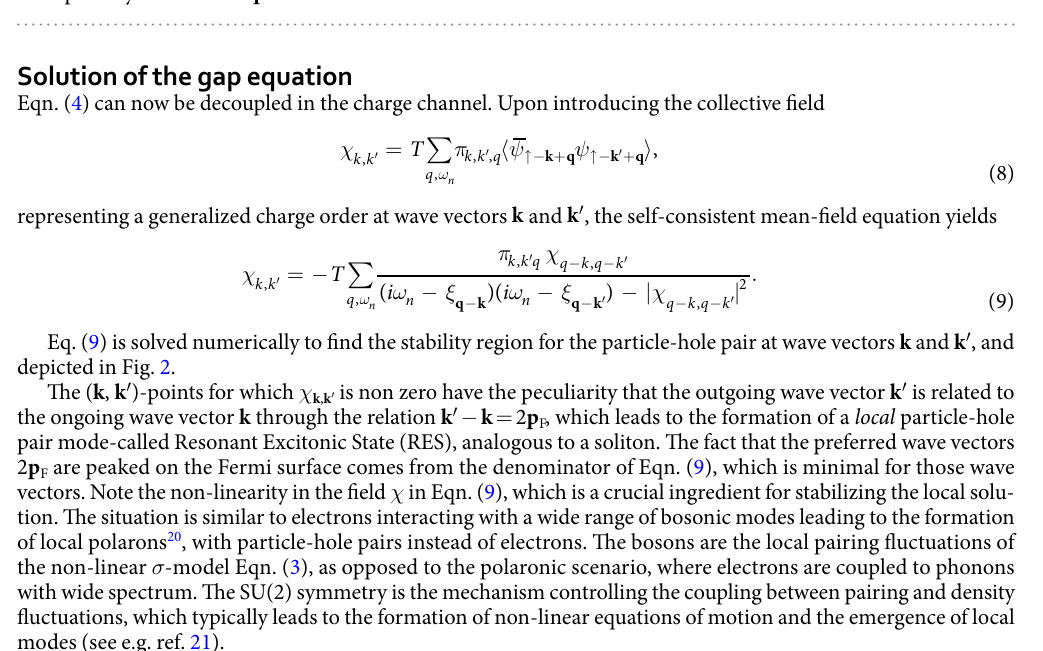
Figure 1. Real part of the charge susceptibility in presence of SU(2) pairing fluctuations. The charge susceptibility is maximal at p = 0 which is the signature of a nematic instability and is non zero along the 2 p F vectors. Note that it exhibits local maxima along p x and p y axes that correspond to the 2 p F vectors of the zone edge. Inset: we draw the Feynam diagram of the charge susceptibility and the mass a the first BZ (the dashed line represents the Fermi surface). The real part of the charge susceptibility is determined after integration over internal Matsubara frequencies at zero temperature and the summation over internal momentum has been performed numerically in the first Brillouin zone with meshes of 200 × 200 at zero frequency. Regarding the bosonic propagator written in equation (3), the main contribution to charge susceptibility is raised for q ≈